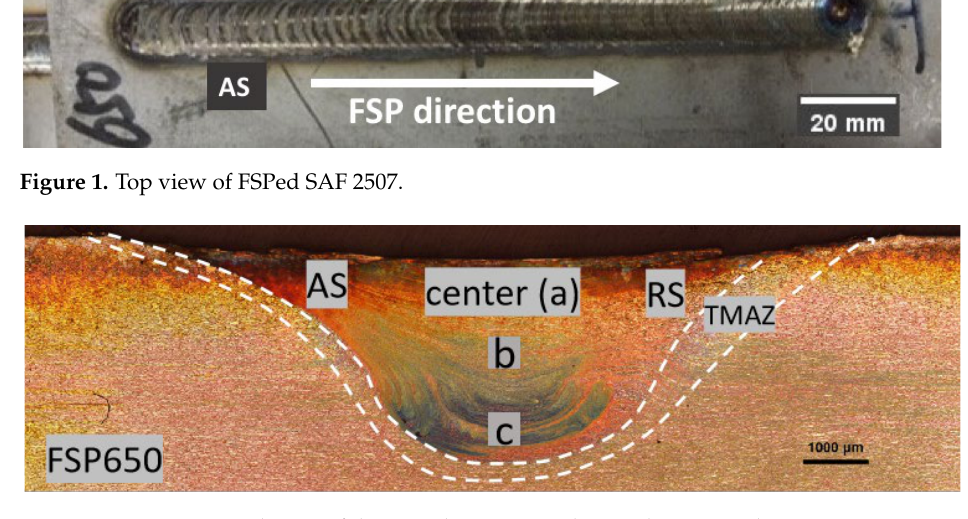
Table 2. Volume fraction of austenite and ferrite in different